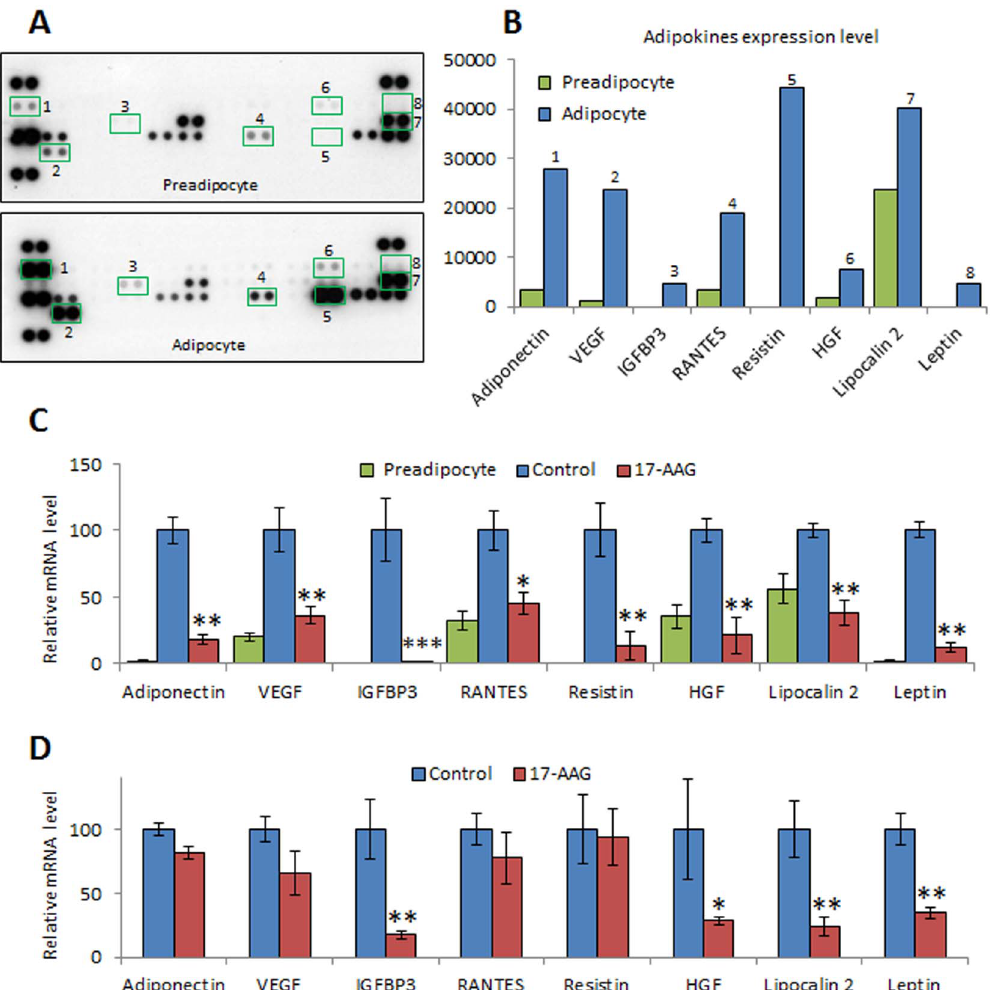
Figure 6. 17-AAG affects adipokines production. (A) 3T3-L1 preadipocytes were induced or not to differentiation. 24 h supernatants from preadipocytes and mature adipocytes were collected and assessed for adipokines expression using an antibody adipokine array. The cytokine level was determined by chemiluminescence detection and autoradiography. Among the 38 cytokines tested, 8 were up-regulated in mature adipocytes. (B) Each dot of the array was quantified using Image J software. (C) 3T3-L1 preadipocytes were induced to differentiation in presence or absence of 17-AAG (100 nM) from the beginning of the differentiation process. The abundance of different adipokines mRNA was measured by quantitative RT- PCR. (D) 3T3-L1 mature adipocytes were treated or not with 17-AAG (100 nM) for 48 h. The abundance of different adipokines mRNA was measured by quantitative RT-PCR. Given are means (n=3) relative to GAPDH 6 SD, *p , 0.05, **p , 0.01, ***p , 0.001 compared to non-treated mature